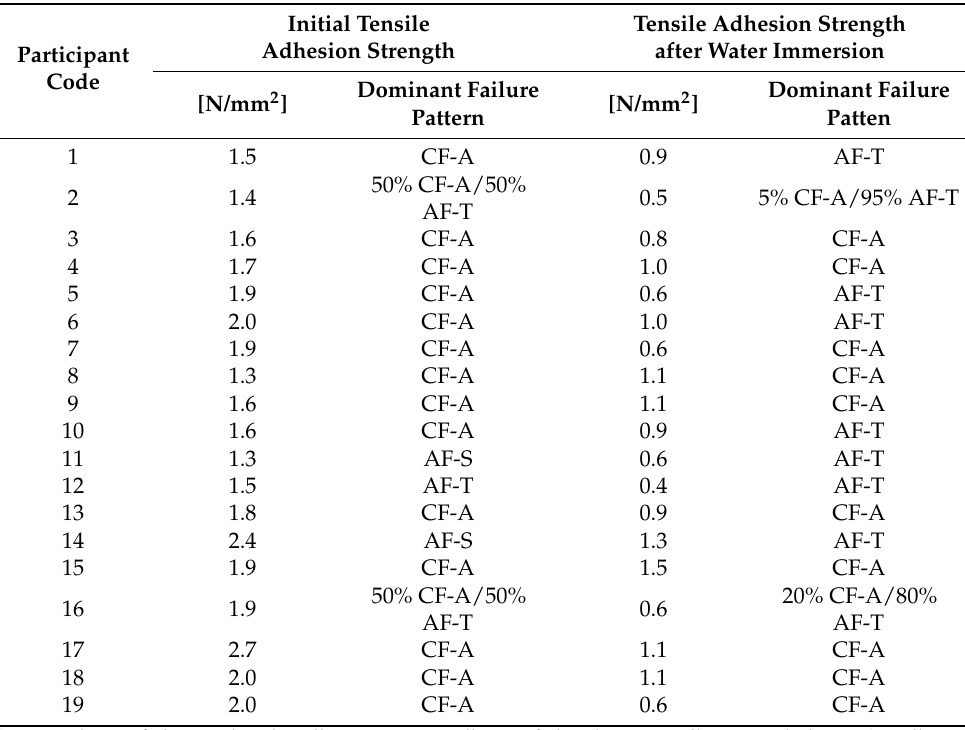
Table 2. The initial tensile adhesion strength and tensile adhesion strength after water immersion of CTA with the predominant mode of failure obtained by 19 laboratories in the twelfth ed. (2020–2021). Initial Participant Code